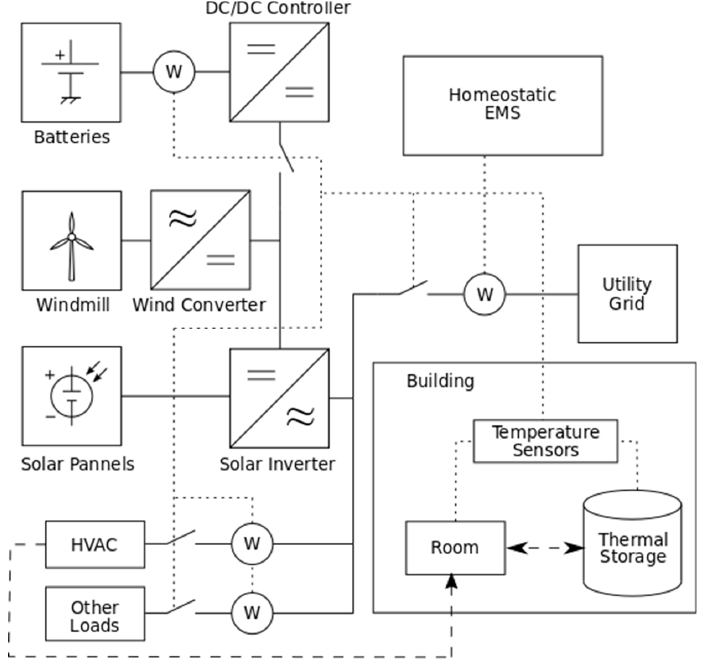
Figure 2. Energy fluxes and control.